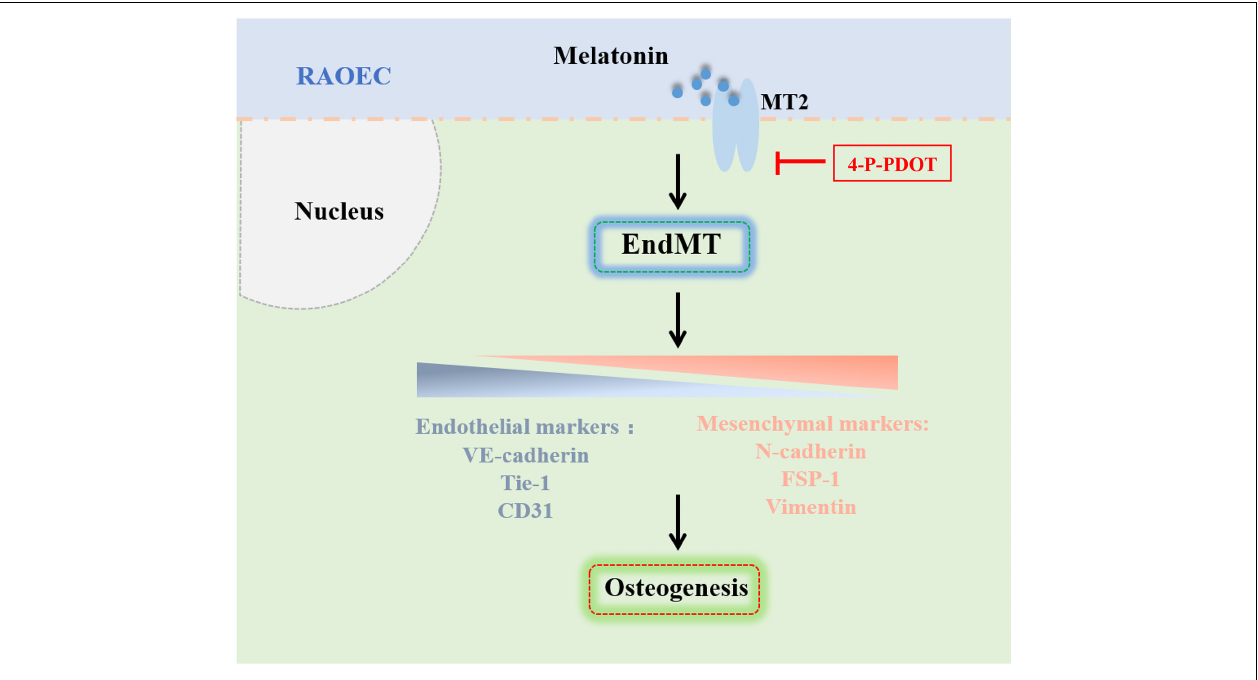
FIGURE 9 | Schematic representation of the mechanism by which melatonin promotes HO formation by regulating EndMT through the MT2 receptor pathway. Melatonin promotes HO formation by inducing EndMT and generating vascular endothelial-derived MSC-like cells through the MT2 melatonin receptor